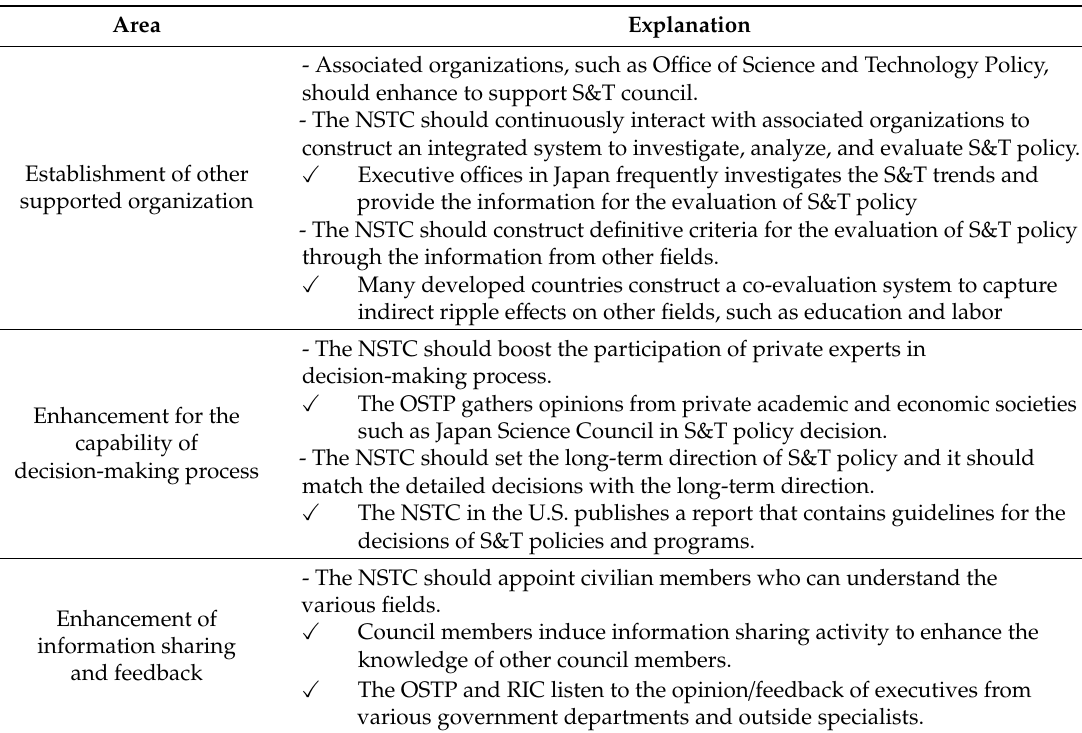
Table 7. Basic directions for operation of